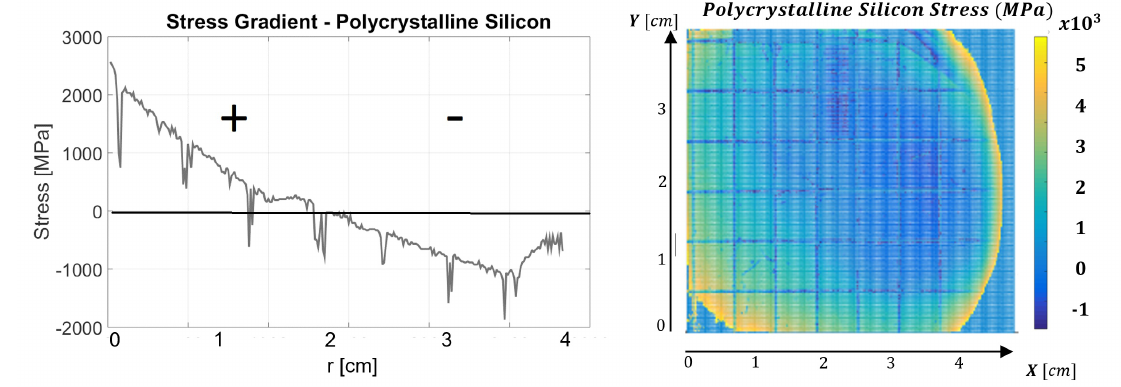
Figure 6. SDP evaluated along a radial line for the PS device (left) and the full surface stress profile (right)